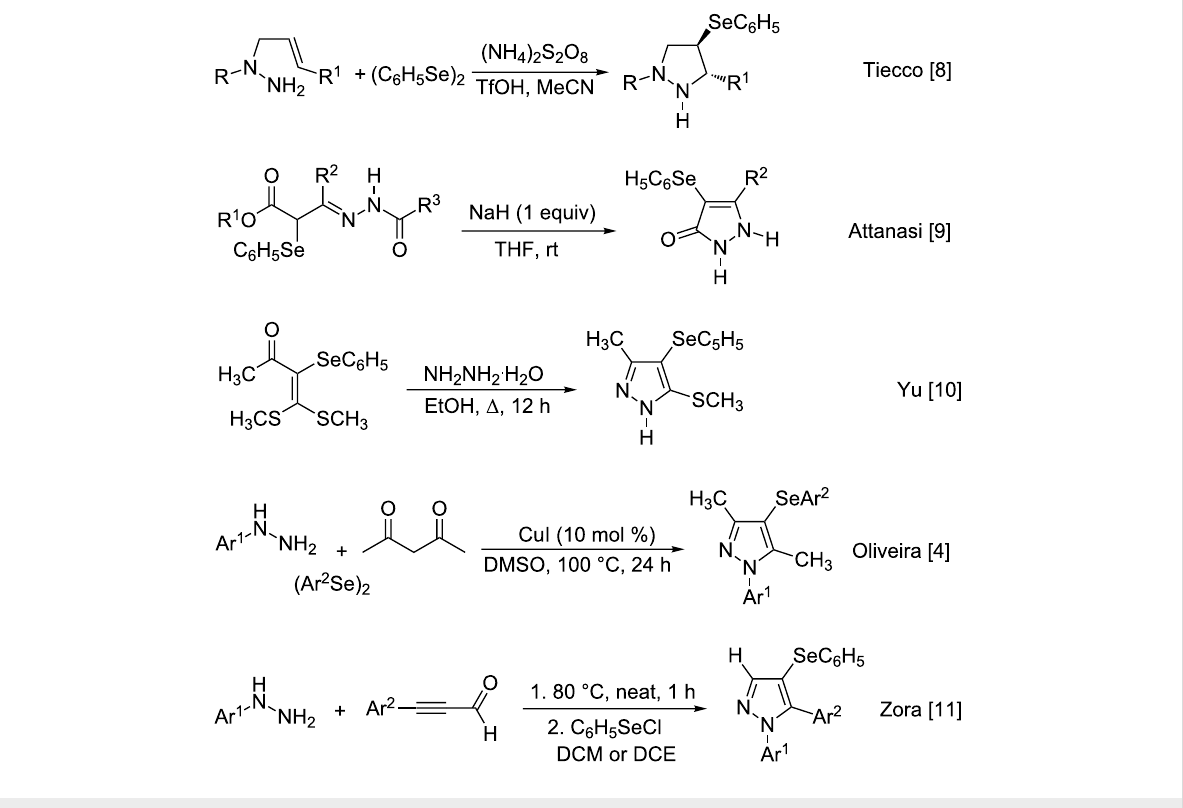
Scheme 1: Synthesis of selanyl-pyrazoles and their derivatives previously